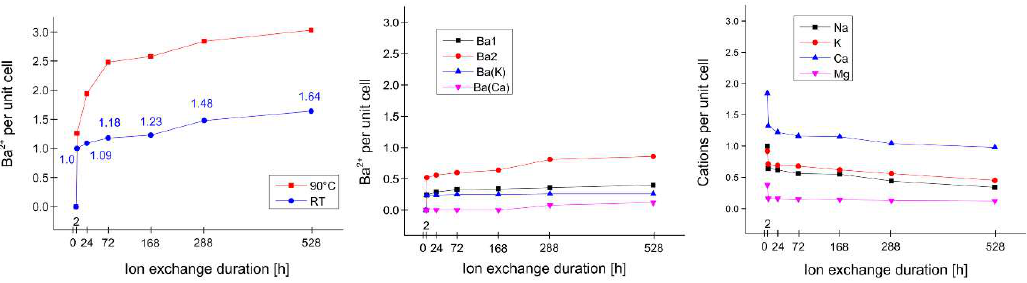
Figure 10. Extent of barium exchange ( left ), barium sites ( middle ) and outgoing cations ( right ) at RT. Concerning the occupancies of the barium positions during ion exchange at room temperature (RT) (Figure 10, middle, Table 8) again position Ba2 (around M3) is mostly exchanged with Ba 2+ but at 22 days is lower occupied (0.86 per unit cell) compared to the exchange at 90 °C. The trend of occupation of position Ba2 with time of exchange is similar to the total barium exchange at room temperature (Figure. 10, left). The other positions are slowly occupied during the same time.